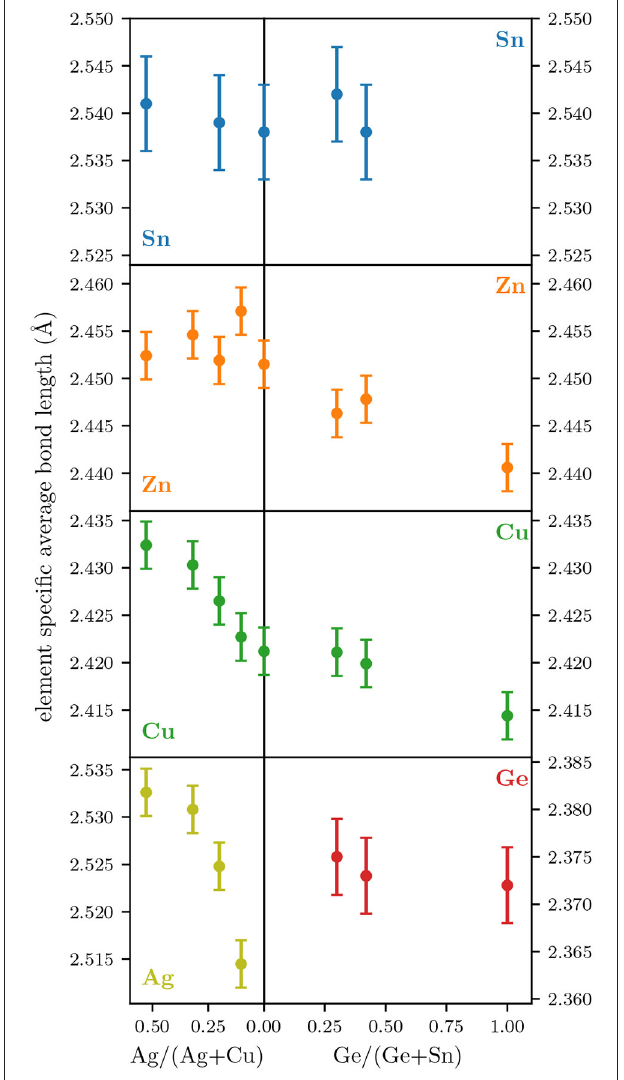
FIGURE 4 | Element specific average bond lengths of all thin films for each cation species as a function of Ag/(Ag+Cu) (left) or Ge/(Sn+Ge) (right) . Note the different scales on the left and right y-axis in the bottom most